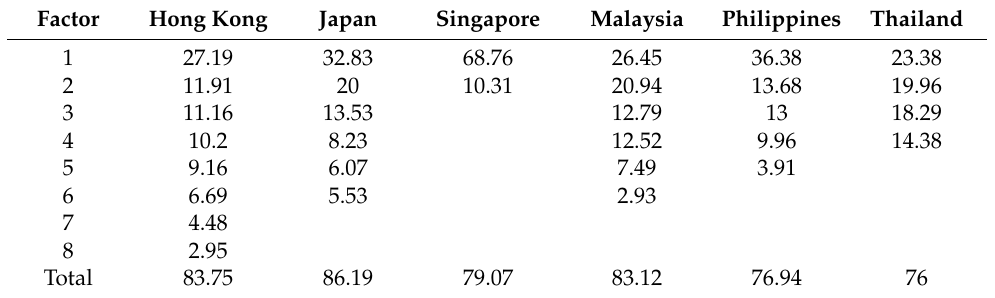
Table 6. Proportion (%) of real estate companies’ P/NAV variance explained by factors extracted. Factor Hong Kong